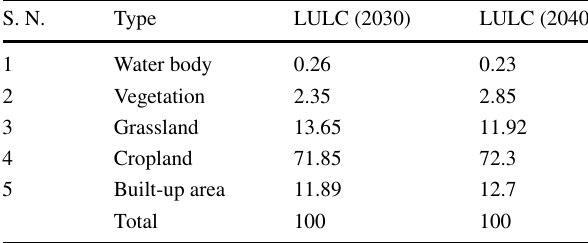
Table 6 Future predication of LULC of 2030 and 2040 S.